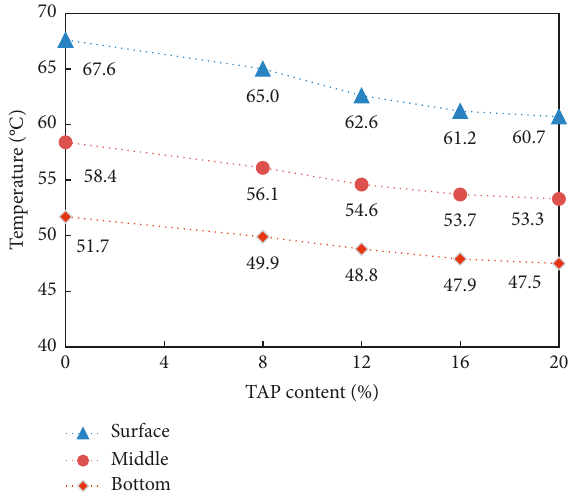
Figure 15: Temperature change of the rutting plate samples with different TAP contents after irradiation using a tungsten iodide lamp for 3 h.